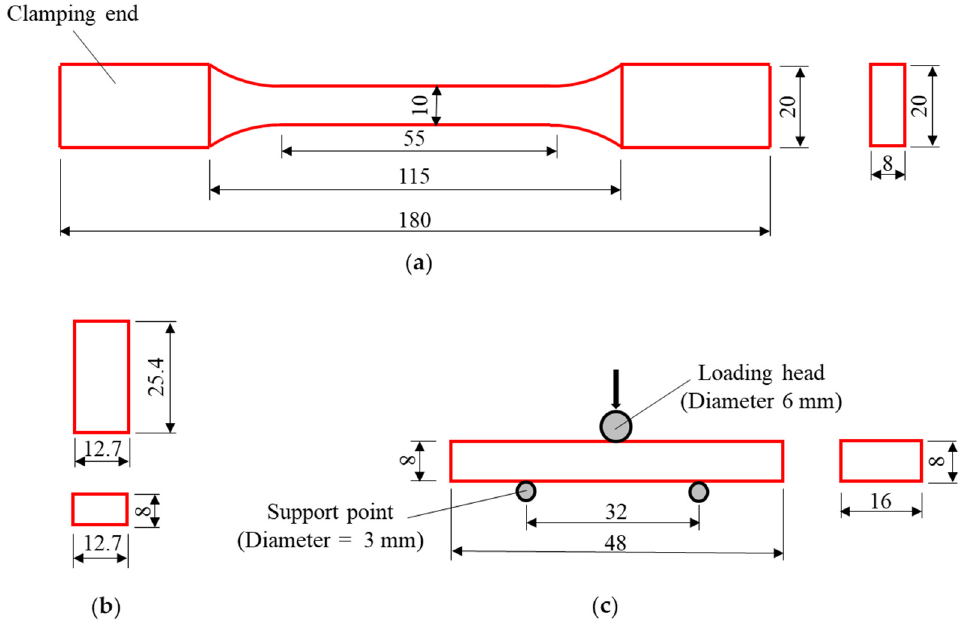
Figure 2. Geometric sizes of material test coupons: ( a ) tensile test, ( b ) compression test, and ( c ) shear test (units in